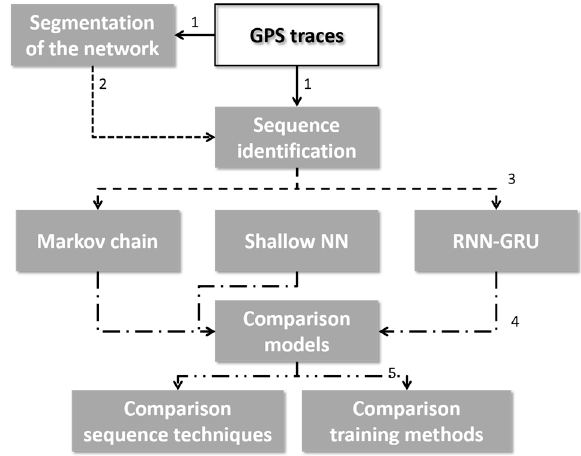
Figure 1. Visualization of the research methodology, where the numbers identify the types of data that are the input of the modules. (1) GPS traces, (2) set of Voronoi cells, (3) Cell sequences, (4) result of model prediction, (5) optimal type of sequence prediction model.